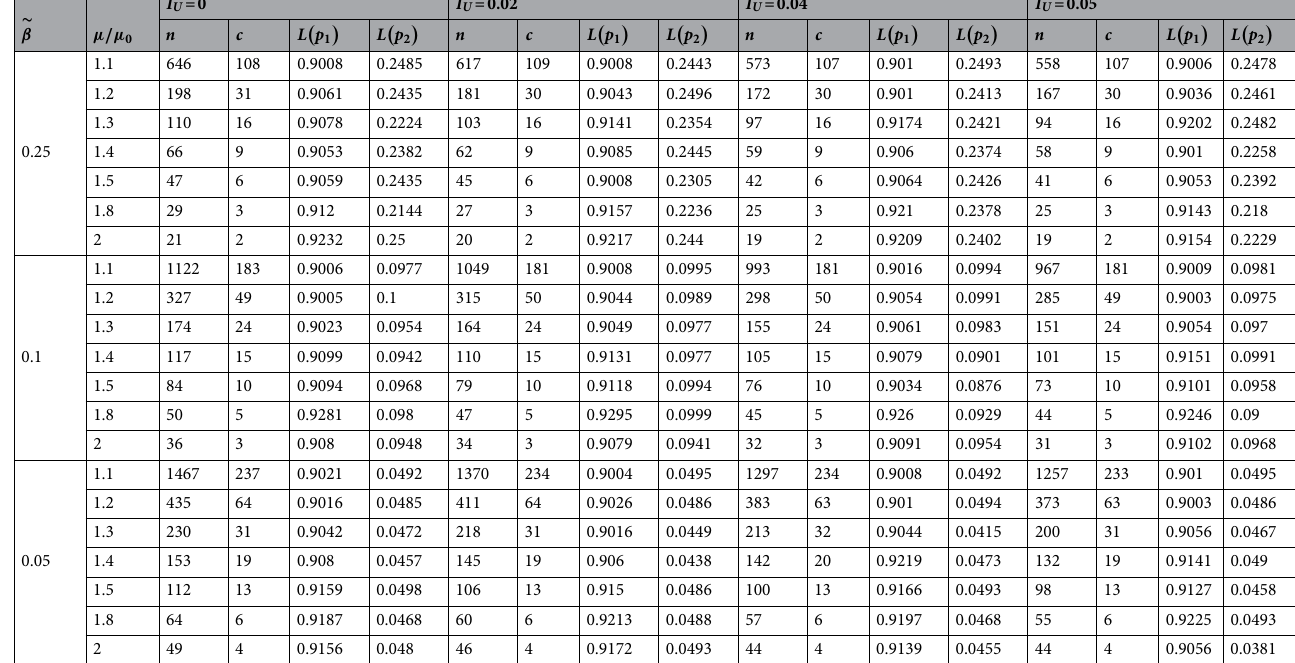
∼ α = 0.10 ; β = 2 and a = 0.50